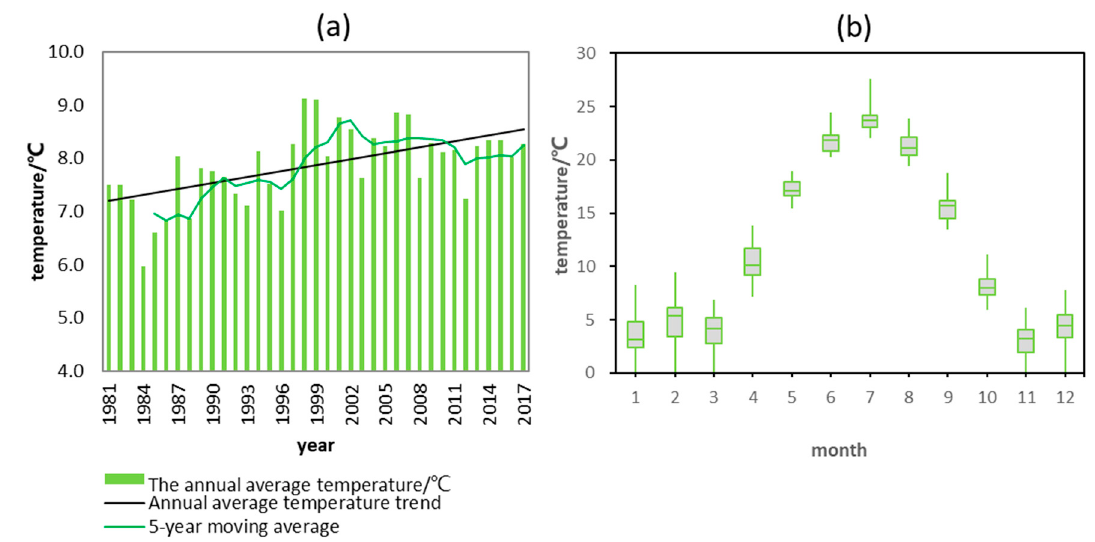
Figure 4. Annual average temperature trend ( a ) and monthly temperature range ( b ).